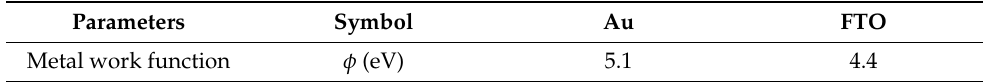
Table 3. Back and front contact